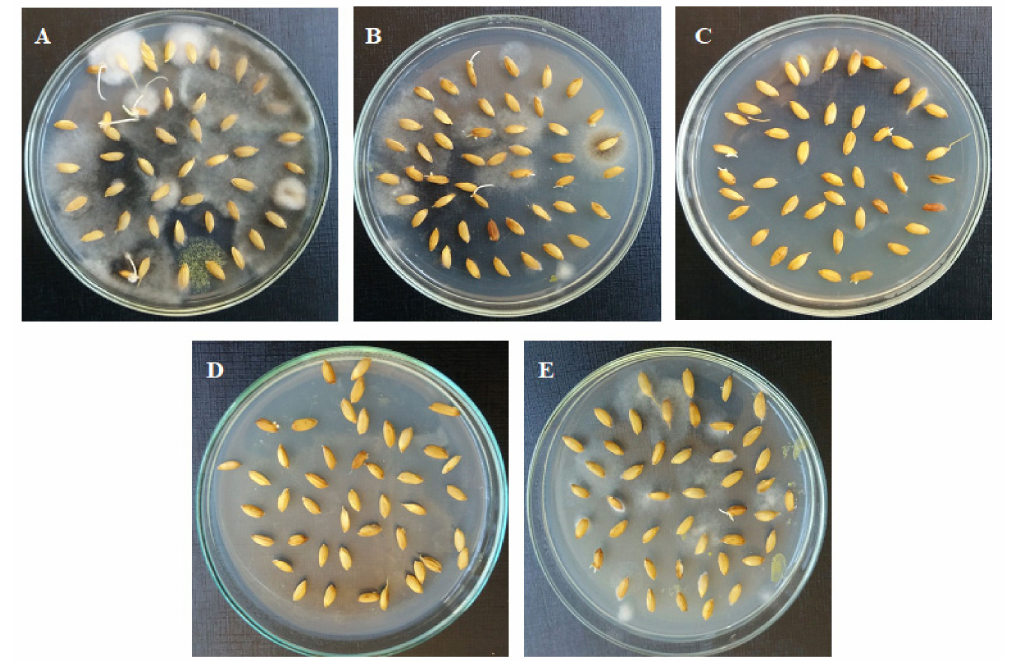
Figure 1. Antifungal activity of essential oils against rice seed-borne fungi of cultivar Giza177 in controlling seed-borne infection of B. oryzae , F. verticilliodies , F. graminearum and C. lunata ; ( A ) control (untreated), and seeds treated with oil from ( B ) untreated plants, ( C ) plants treated with Trp, ( D ) with AA, and ( E ) with